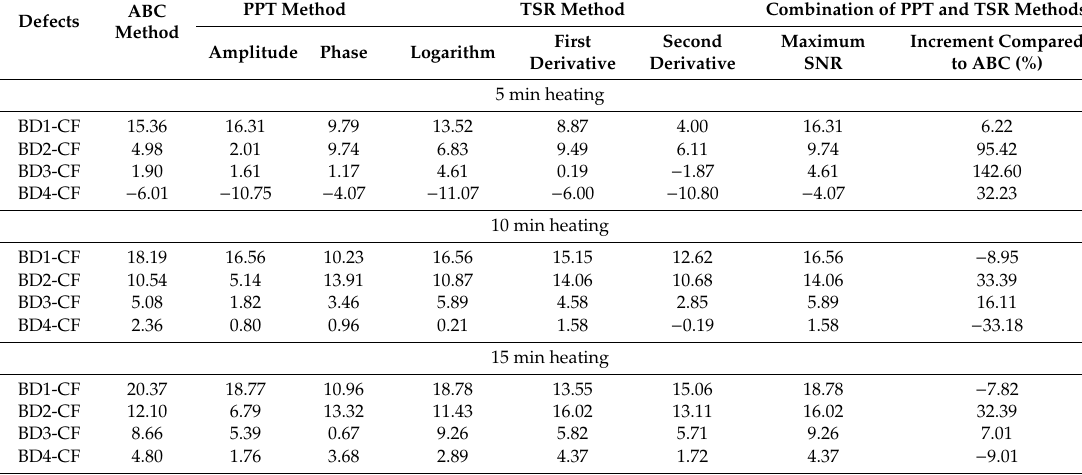
Table 2. Maximum SNR (dB) of defects using di ff erent algorithms under 5, 10, and 15 min heating from